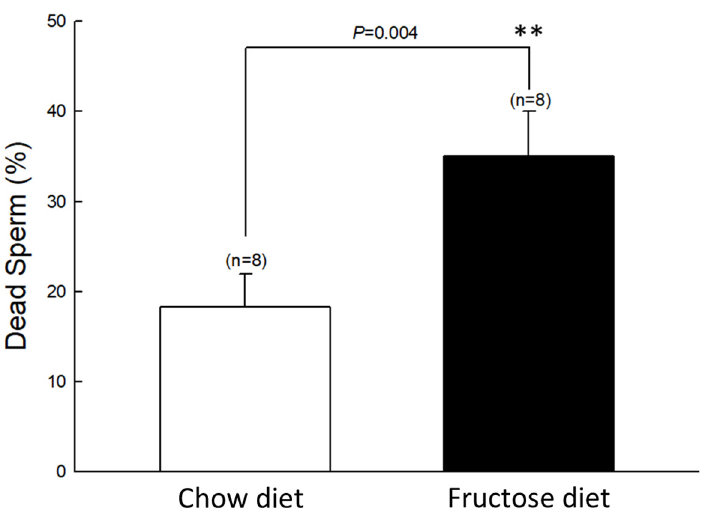
Figure 2. Effects of the fructose diet-fed on sperm motility. Semen was collected from the epididymis and put on the warmed slides; thereafter, the percentage of sperm motility was examined. ** p < 0.01 as compared to the control group (white column). Each value presents mean ± SEM. Similar results were repeated